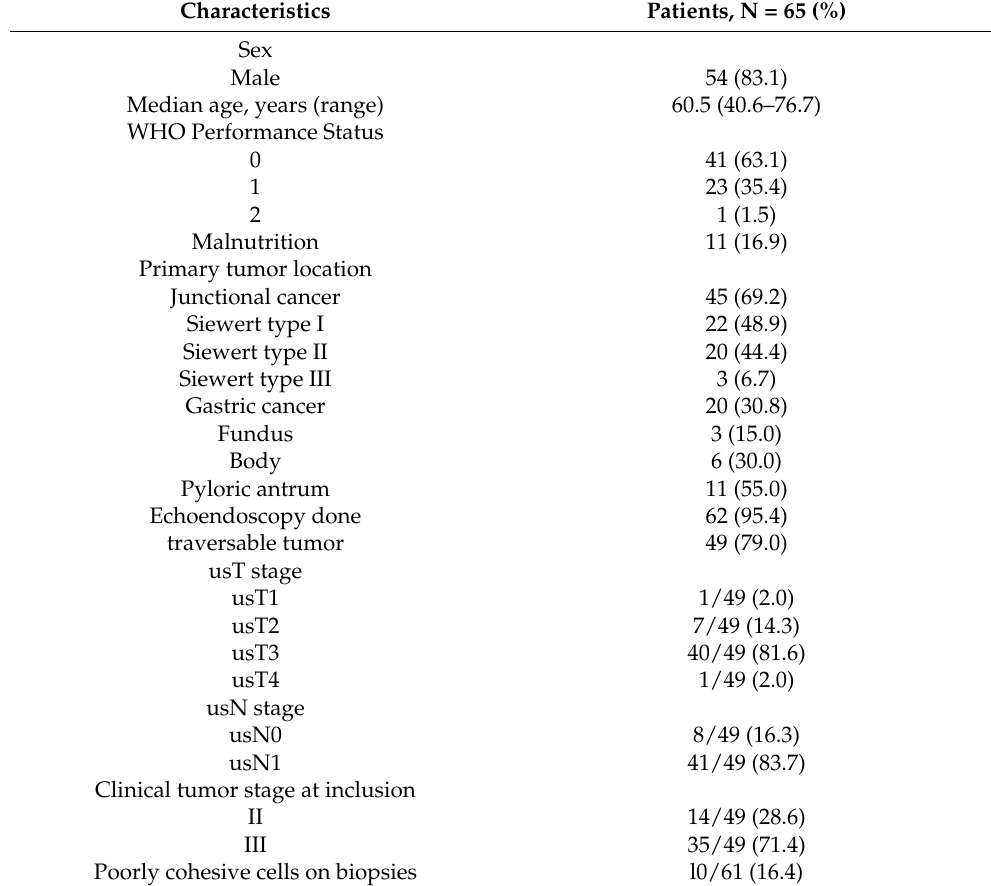
Table 1. Patient and tumor characteristics at